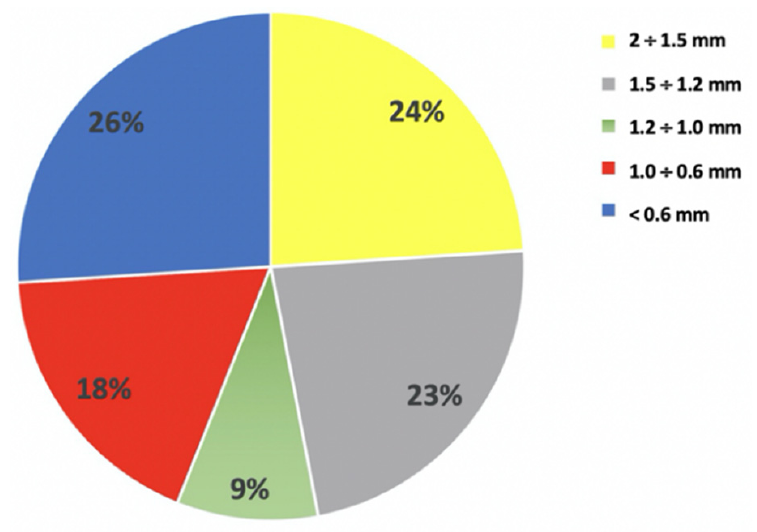
Figure 1. Particle size percentage composition of fines.